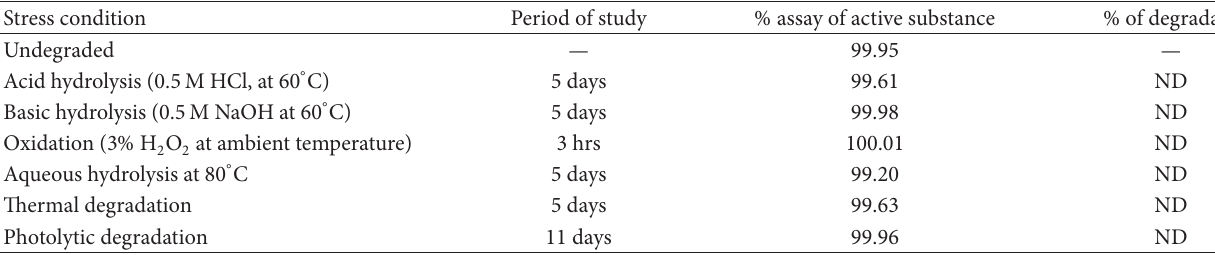
T 2: Forced degradation study